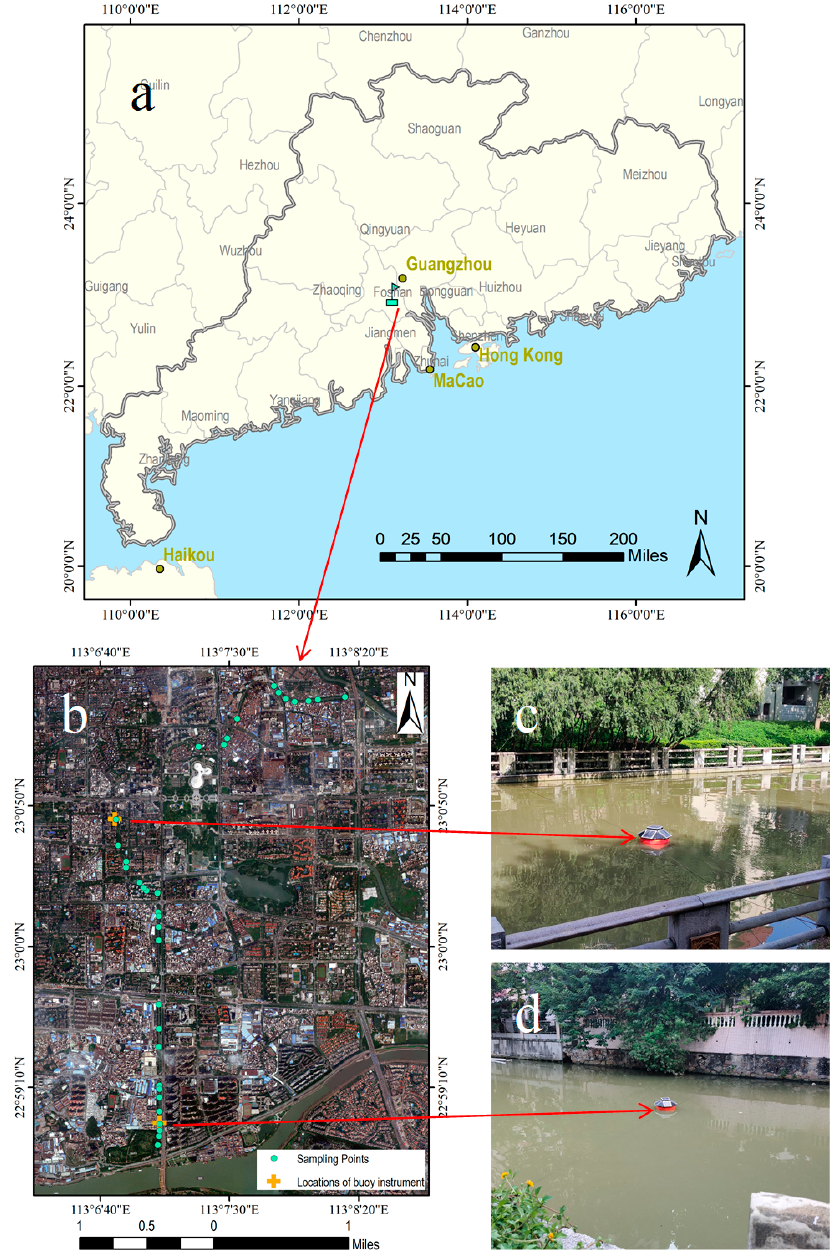
Figure 1. The geographic location of the study area and the selected sampling positions. ( a ) Map showing the location of the study area, Foshan, Guangdong province, China. ( b ) 36 water quality sampling points are distributed along the river. During the acquisition of hyperspectral data by UAV, two buoy hyperspectral sensors were set up simultaneously in the middle and downstream of the river. ( c ) The first buoy hyperspectral sensor, No. A. There is some shadow interference in this position. ( d ) The second buoy hyperspectral sensor, No. B. There are no shadows in this position.